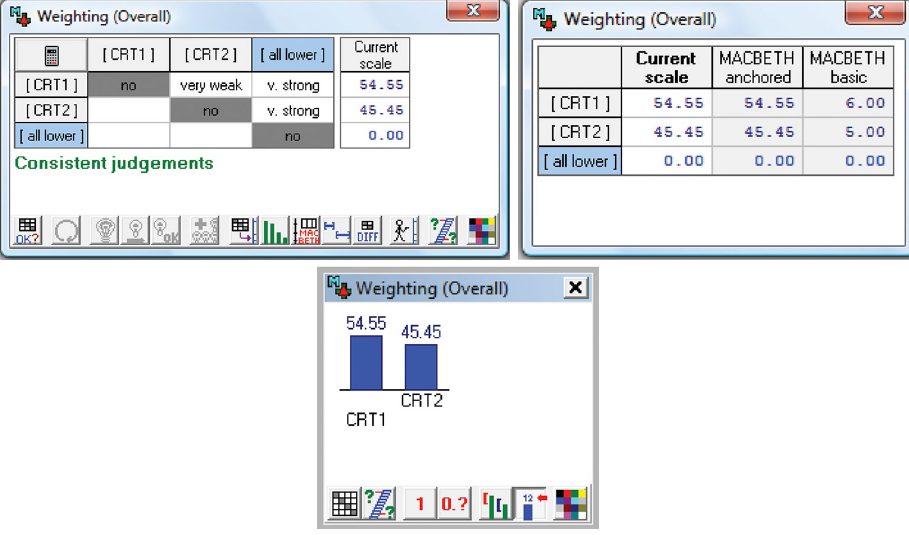
Fig. 6. Value judgements, proposed scales and criteria weights Source: Adapted from Ferreira